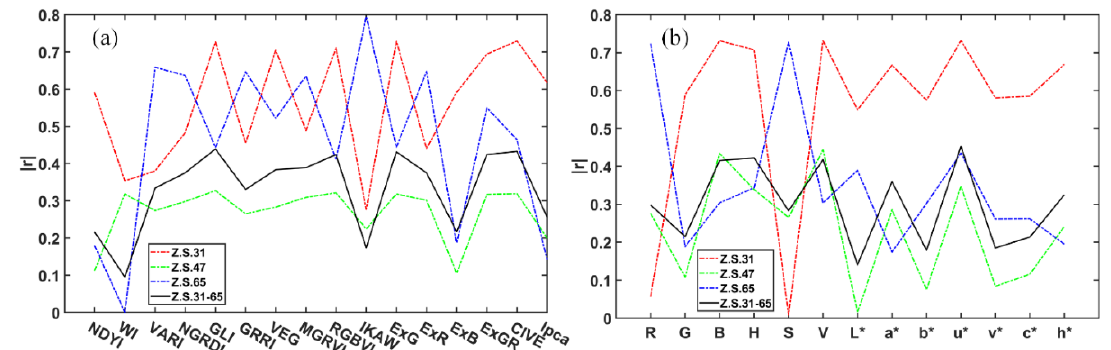
Figure 14. Correlation analyses of PND with ( a ) RGB-based VIs and ( b ) color parameters in terms of the growth stage based on the calibration dataset.